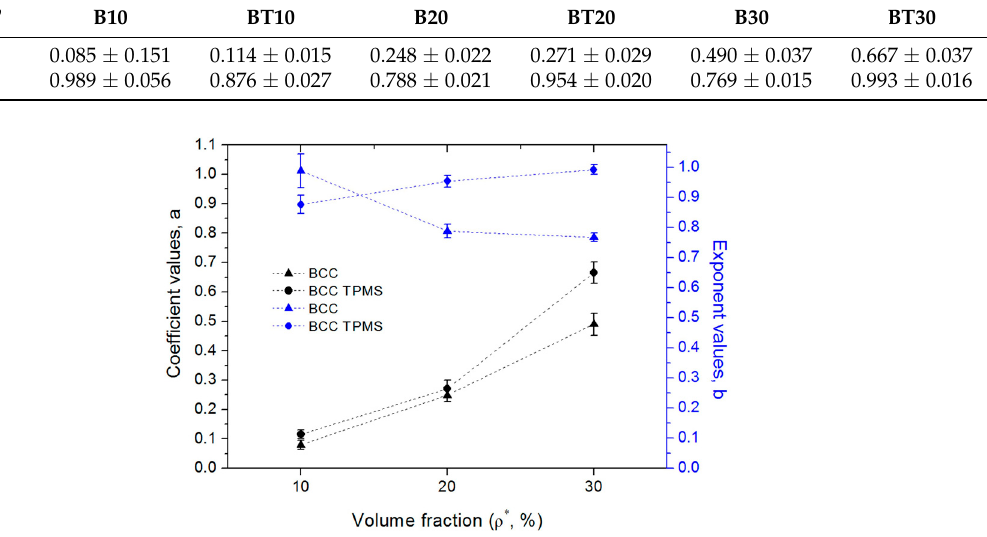
Figure 14. The fitted resulted coefficient values ( a ) and exponent values ( b ) of energy absorption curves (three replicate specimens, means and standard deviations).